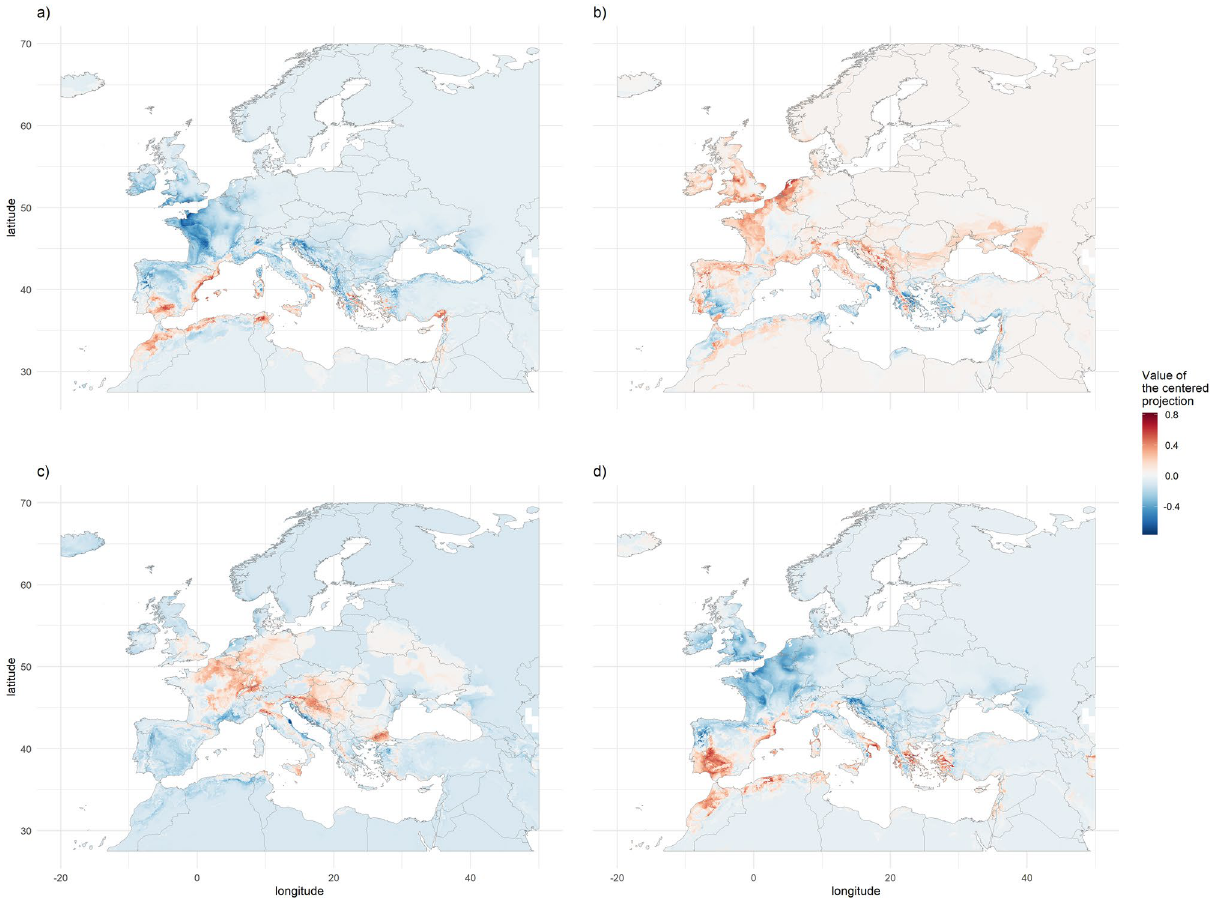
Figure 4. Illustration of the variability between the GCMs used to create consensus maps using centered and standardised maps. These display a negative value when the GCM considered predicts a lower suitability than the average of all GCMs and a positive value otherwise. A and B correspond to two GCMs (MG and MI respectively) used to compute the RCP2.6 maps for the year 2050, C and D represent two GCM (HD and MG respectively) used to compute the RCP8.5 for the year 2070. The maps were generated using R 4.0.0 (https :// cran.r-proje